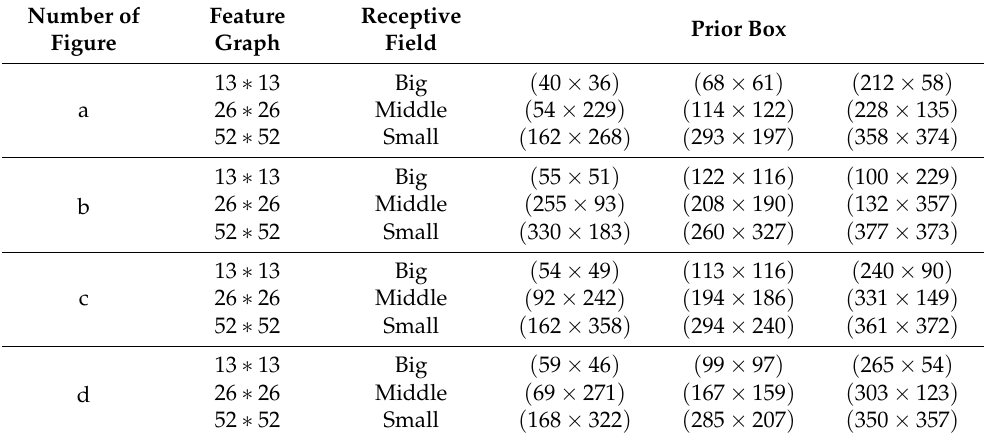
Table 4. Cluster prior